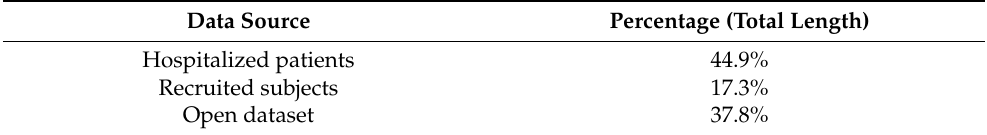
Table 1. Constitution of input data